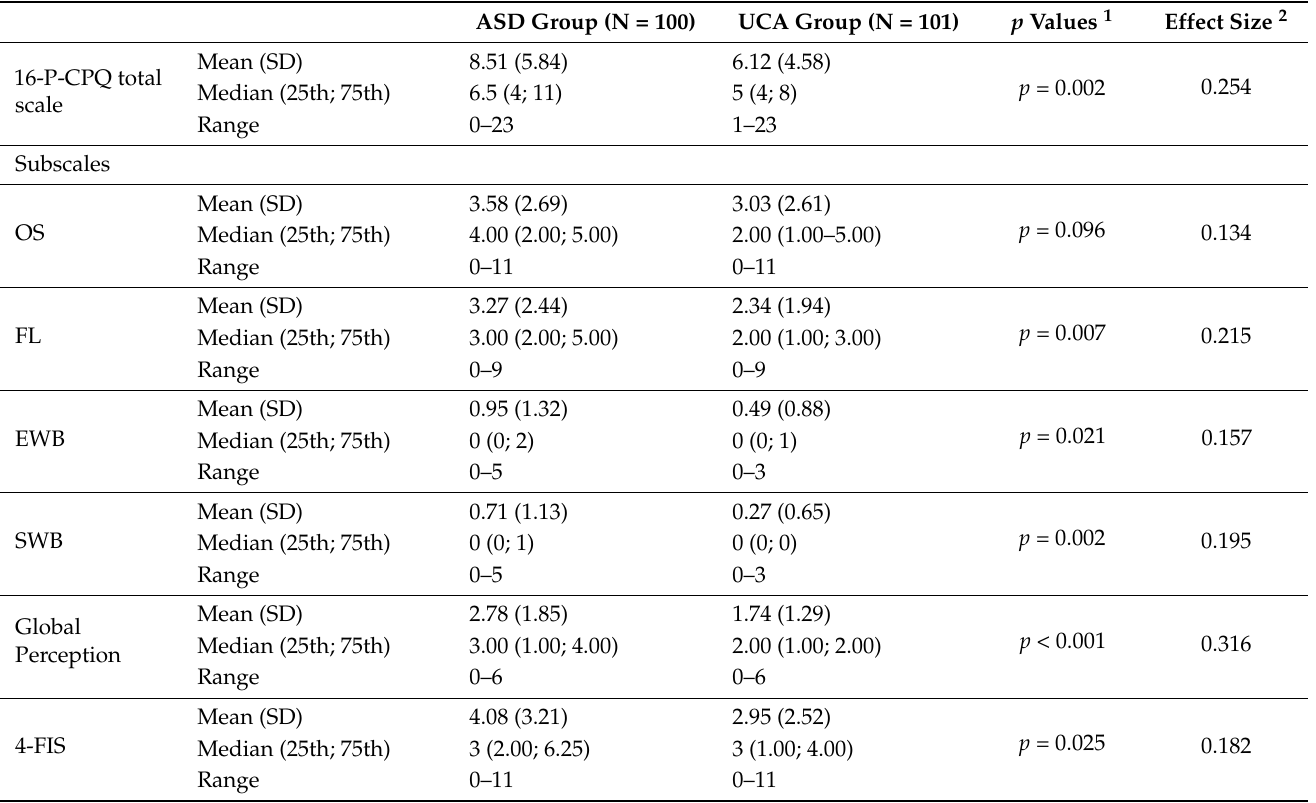
Table 2. Descriptive data of the questionnaires (16-P-CPQ total, subscales, global and 4-FIS). ASD Group (N = 100) UCA Group (N = 101) p Values 1 Effect Size